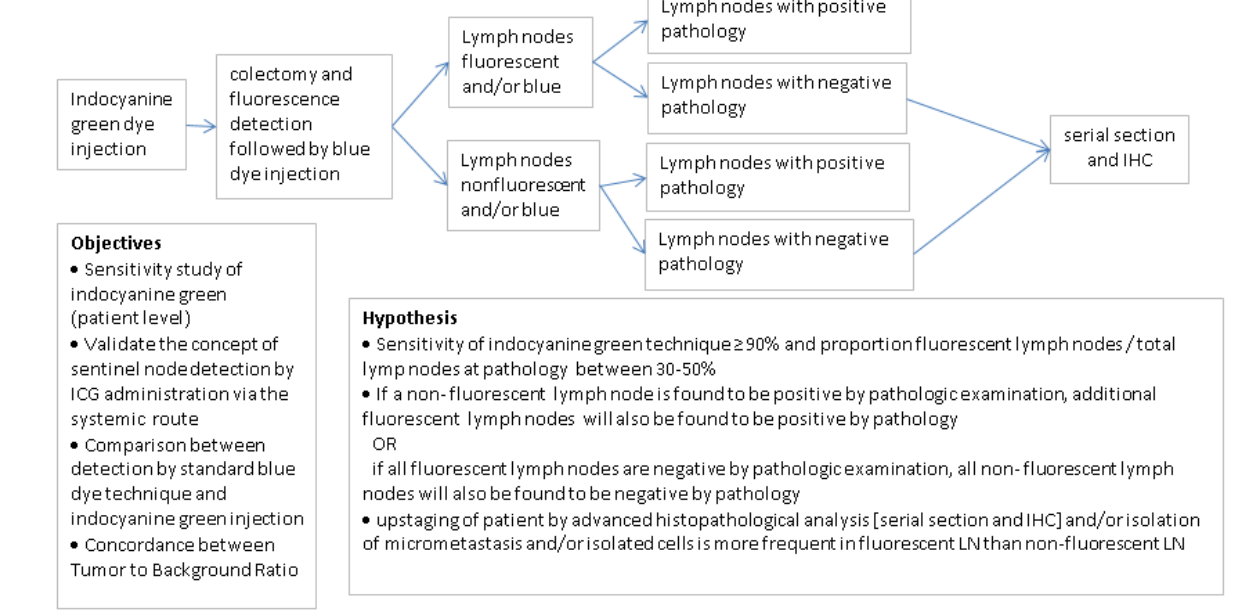
Figure 4. Flow of samples through the study. After indocyanine green and blue dye injection, all lymph nodes removed during colectomy will be analysed for indocyanine green fluorescence and blue dye positivity, followed by pathologic analysis. Lymph nodes that are negative by initial pathology will be further examined by serial sectioning. ICG: indocyanine green; IHC: immunohistochemistry; LN: lymph